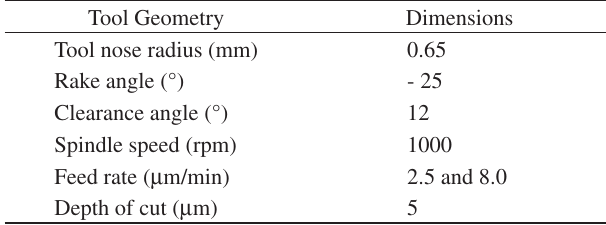
Table 1. Tool geometry and cutting conditions used in the cutting tests.